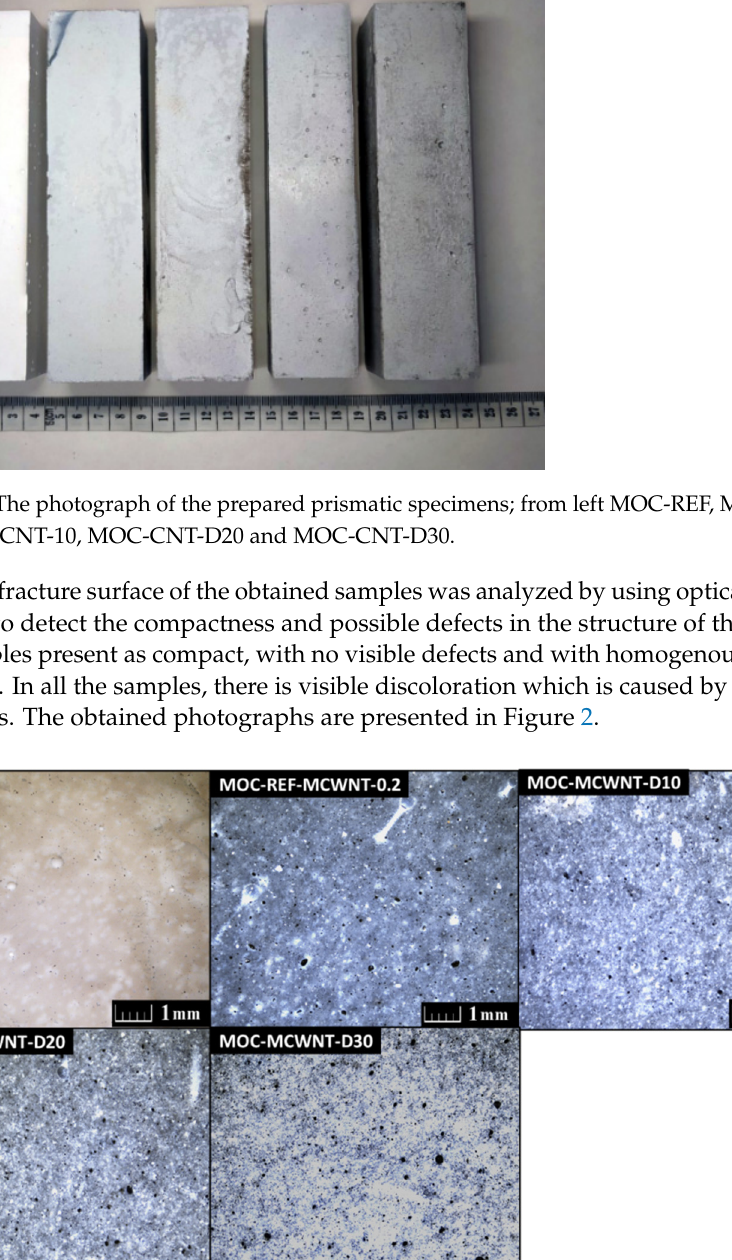
Figure 1. The photograph of the prepared prismatic specimens; from left MOC-REF,